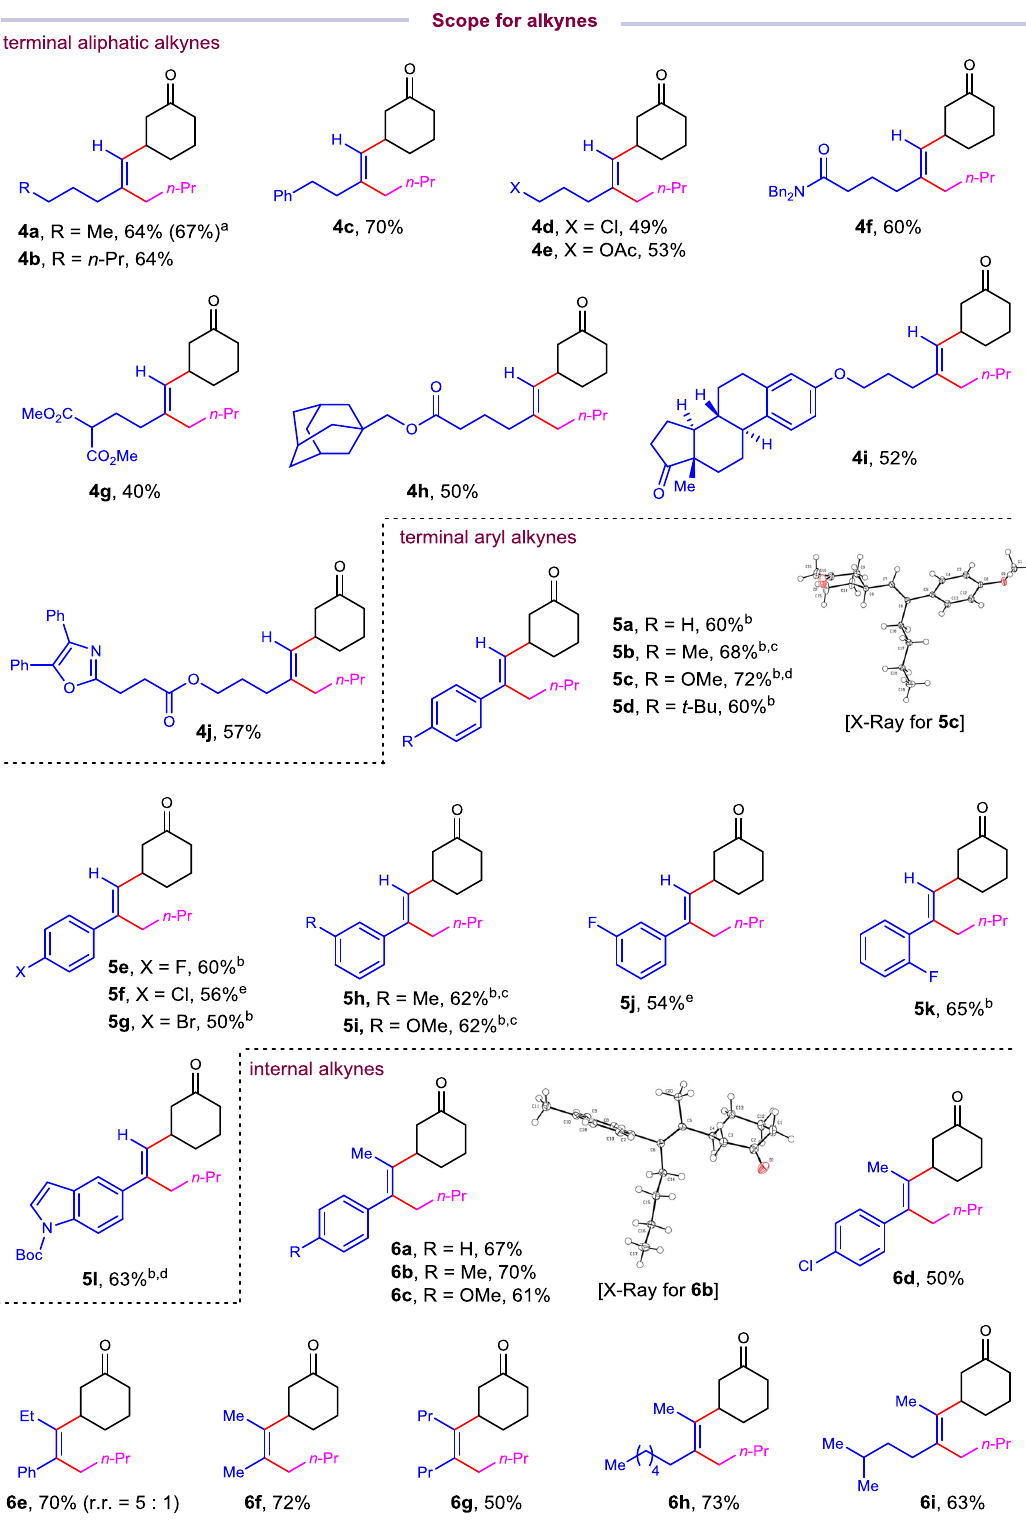
Fig. 2 Scope for the syn -cross-electrophile dialkylation of alkynes with respect to alkynes. Unless otherwise noted, isolated yield is shown on 0.2 mmol scale under standard conditions. See Table 1, entry 1 for detail. a Isolated yield on 10.0 mmol scale. b NiBr 2 ·DME (10 mol%), A2 (20 mol%), Zn (2.5 equiv), KI (2.0 equiv), ZnBr 2 (10 mol%), 2-methyl-2-butanol (2.0 equiv), DMF (0.1 M), rt, overnight. c Alkyne was added in two portions. 1.0 equiv alkyne was added after 5 h. d Alkyne was added in two portions. 1.0 equiv alkyne was added after 3 h. e Alkyne (2.0 equiv), enone (0.2 mmol), alkyl bromide (3.5 equiv), NiBr 2 ·DME (10 mol%), Zn (5.0 equiv), CsI (5.0 equiv), ZnI 2 (30 mol%), 2-methyl-2-butanol (3.0 equiv), DMF (0.05 M) and 1.0 equiv alkyne was added after 3 h, rt,